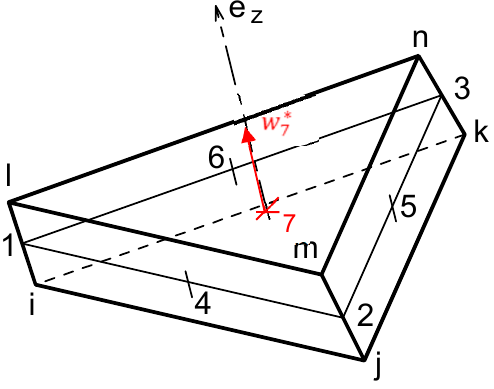
Figure 7. Seven-node prismatic solid-shell element for the consolidation simulation.